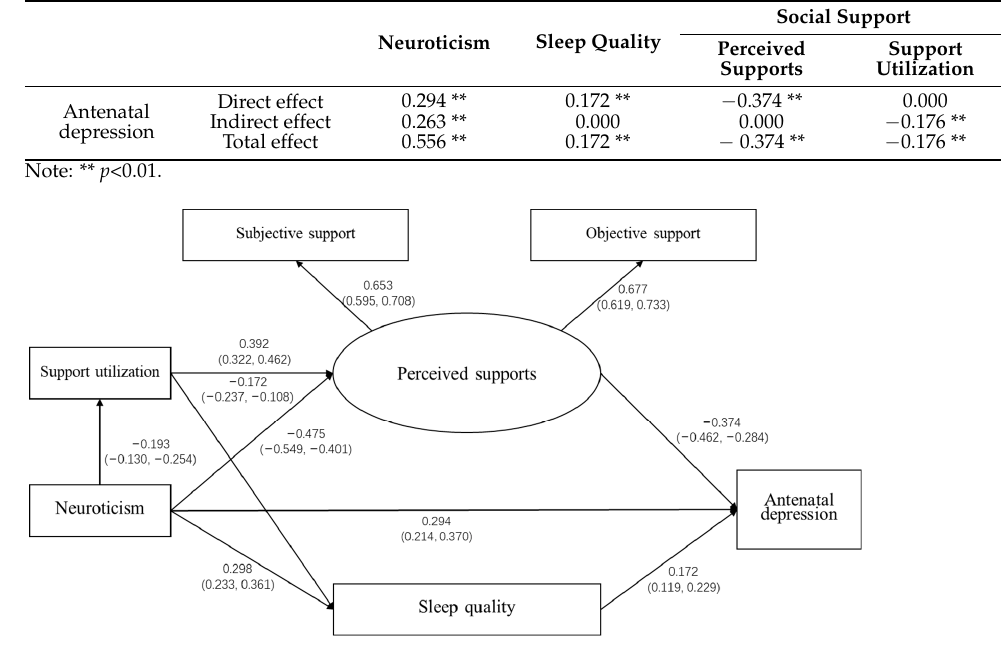
Figure 2. The standardized path model (pathways from neuroticism, social support, and sleep qual- ity to antenatal depression during the third trimester of pregnancy). Note : (1) Sleep quality was as- sessed using the Pittsburgh sleep quality index (PSQI). A higher score of the PSQI means worse sleep quality.